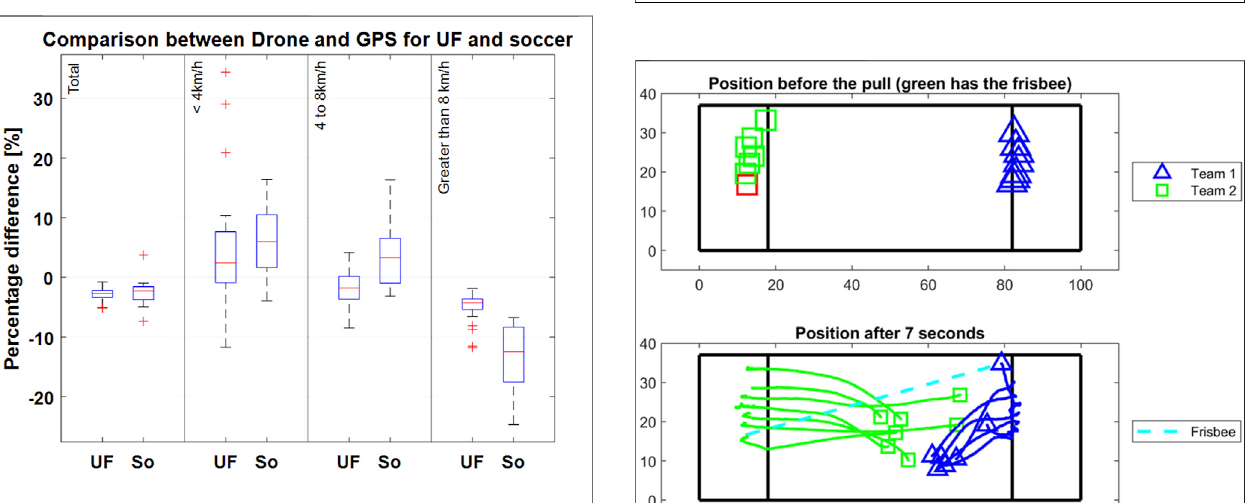
FIGURE 6 | Percentage deviation of the total distance measurements between the drone-based video system and GPS in Ultimate and soccer for different speed zones. Boxplots show the respective median (red line); the bottom and top edges of the box indicate the 25th and 75th percentiles (blue box). The whiskers extend to the most extreme data points without considering any outliers ( “ + ” symbol). UF (Ultimate Frisbee), So (soccer small- sided game).